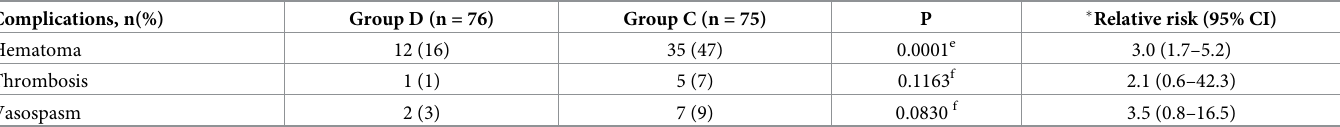
Table 3. Cannulation related complications. Complications,